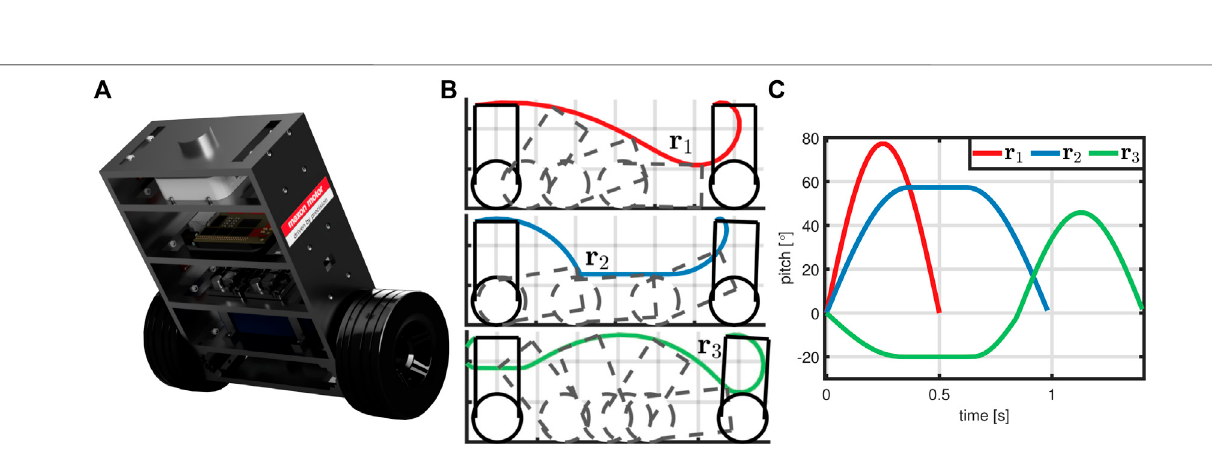
Frontiers in Robotics and AI |